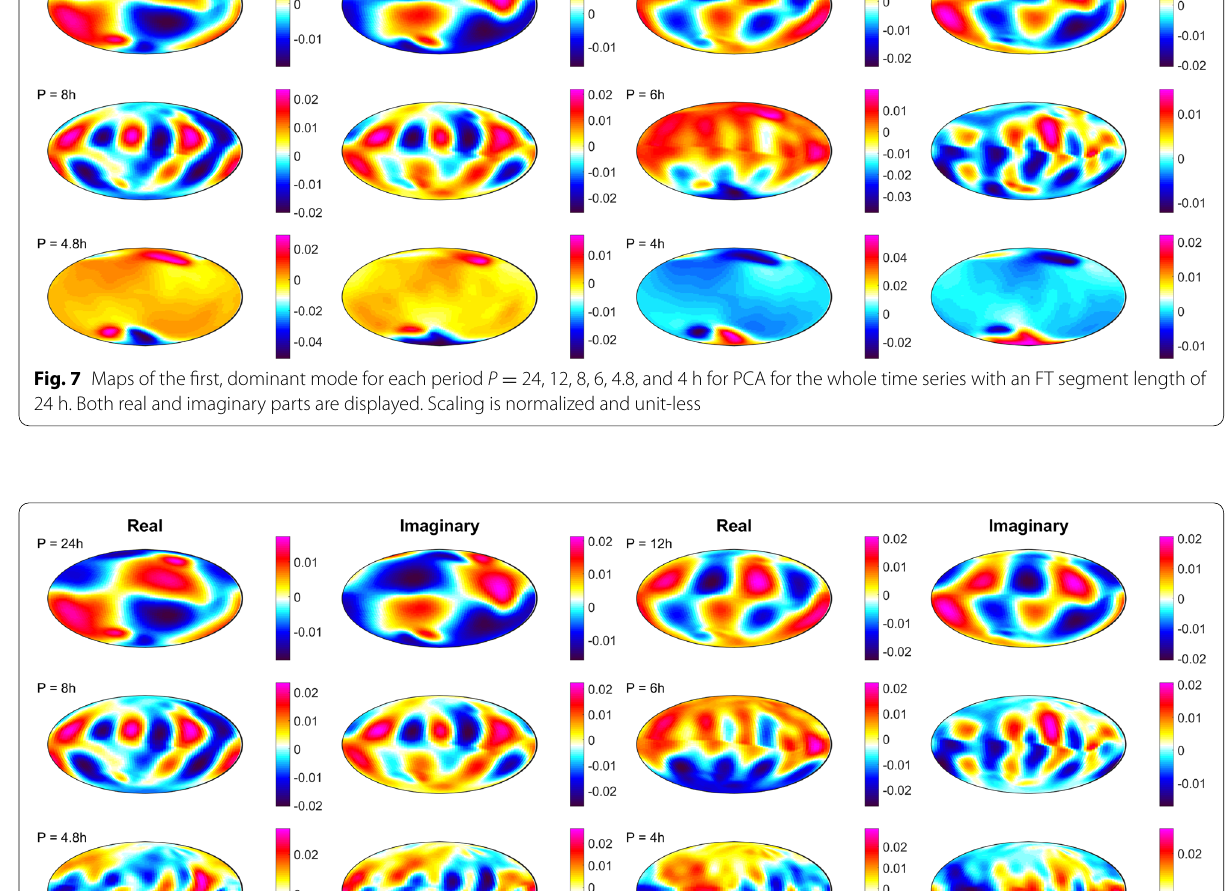
24, 12, 8, 6, 4.8, and 4 h for PCA for the whole time series with an FT segment length of =